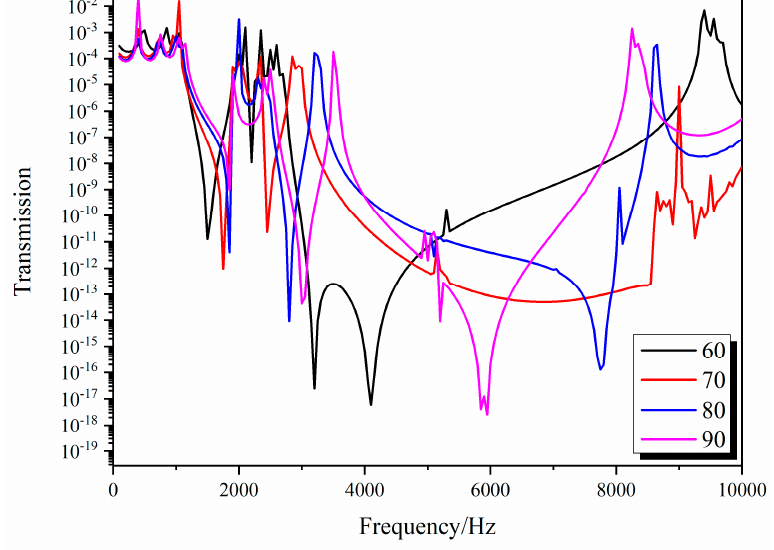
Figure 8. Dependence of the transmission curves of the 3D Star structure on θ .